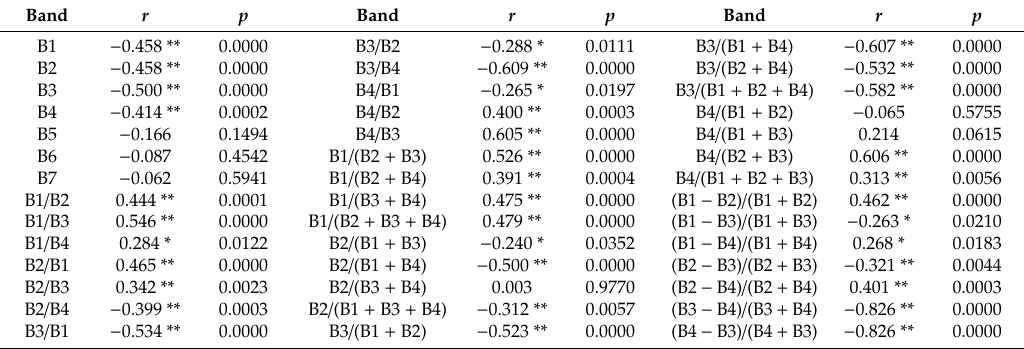
Table 4. Correlation coe ffi cient of Landsat-8 OLI band combinations with Chl-a concentration.